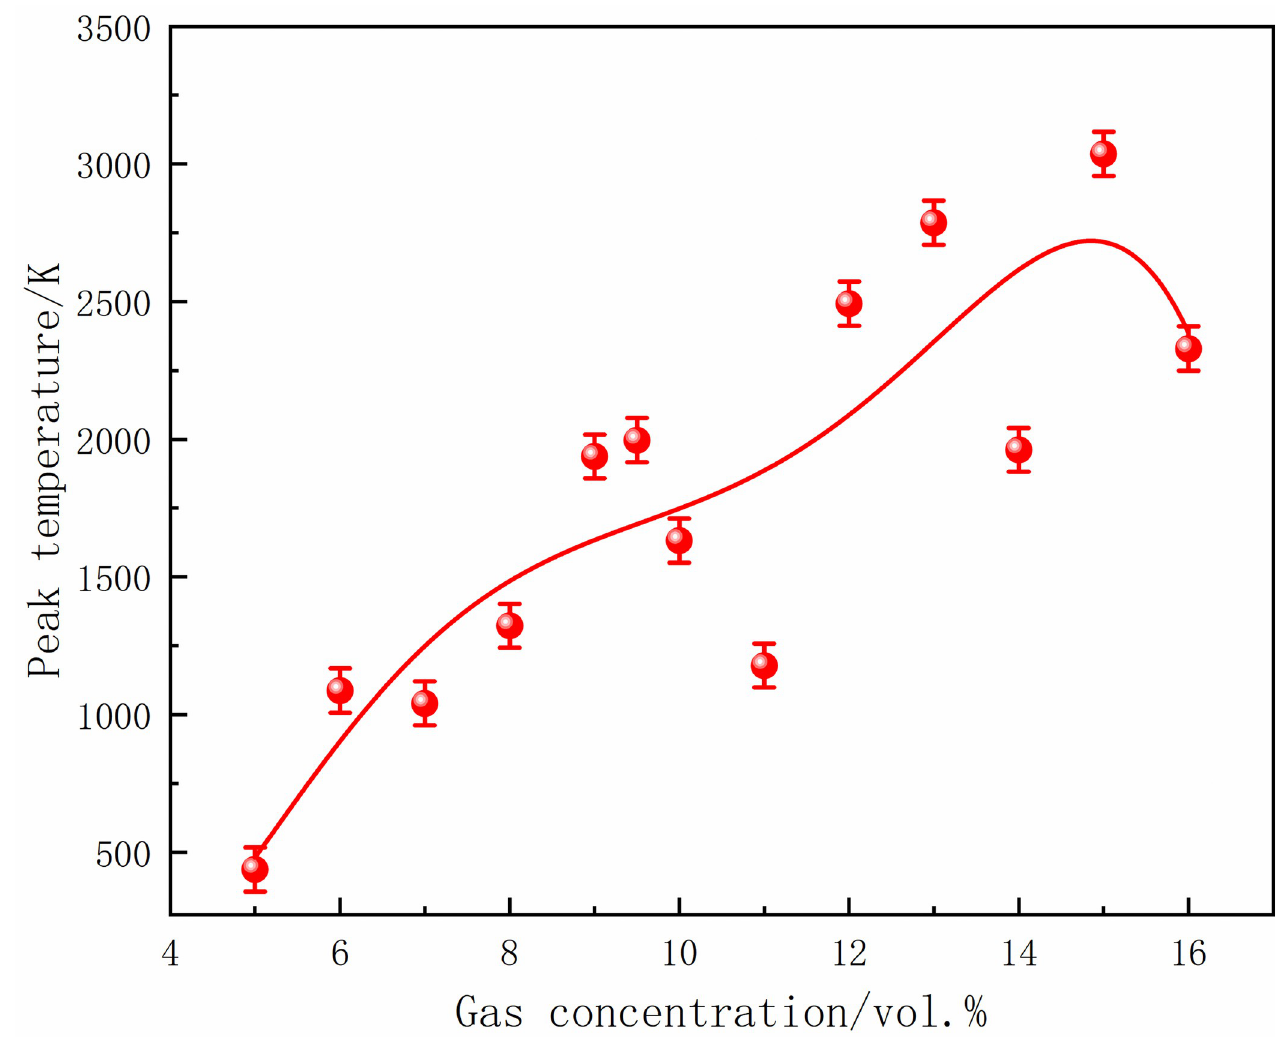
Fig 29. Temperature peaks at different local gas concentrations at the monitoring point